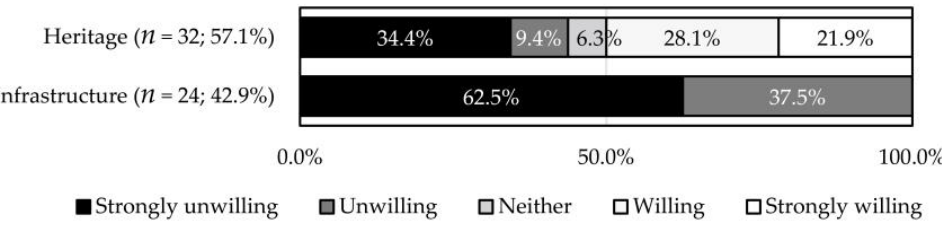
Figure 7. Cross analysis of the willingness for continuous use with heritage identity ( p = 0.000).